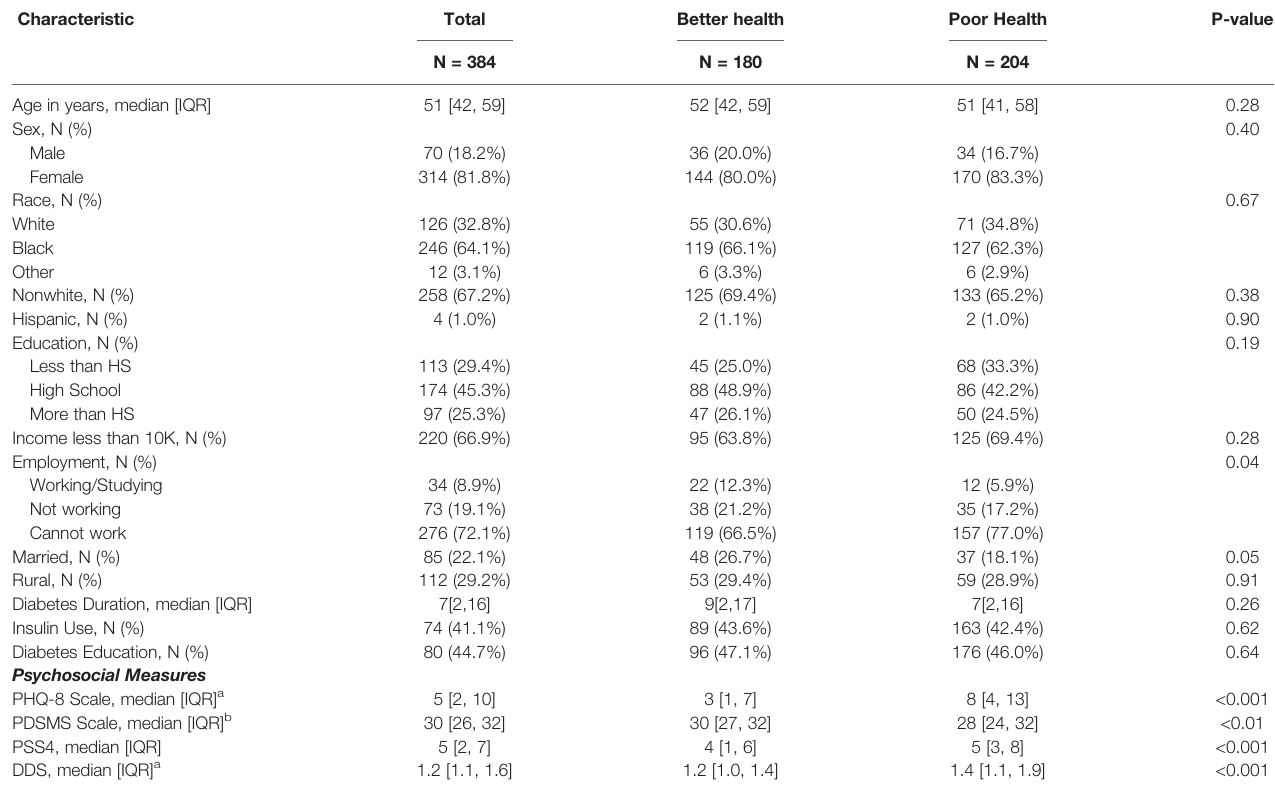
TABLE 3 | Comparison of during-COVID survey participants with type 2 diabetes mellitus by self-reported health status. Characteristic Total Better health Poor Health